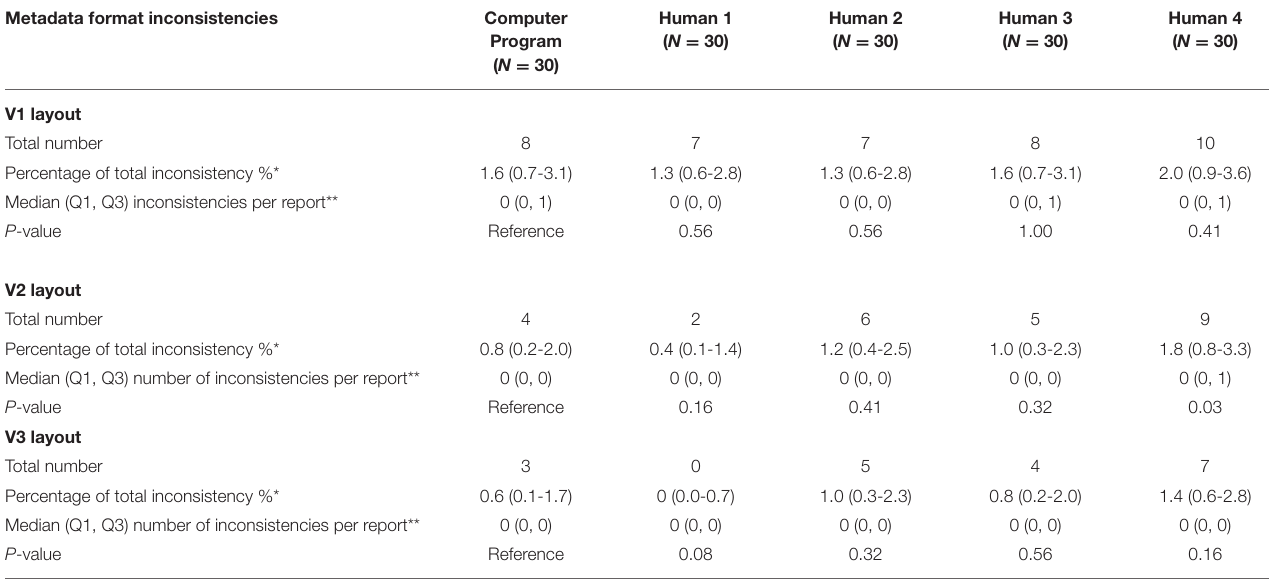
TABLE 3B | Comparison between computer program and human metadata extraction (format inconsistencies).